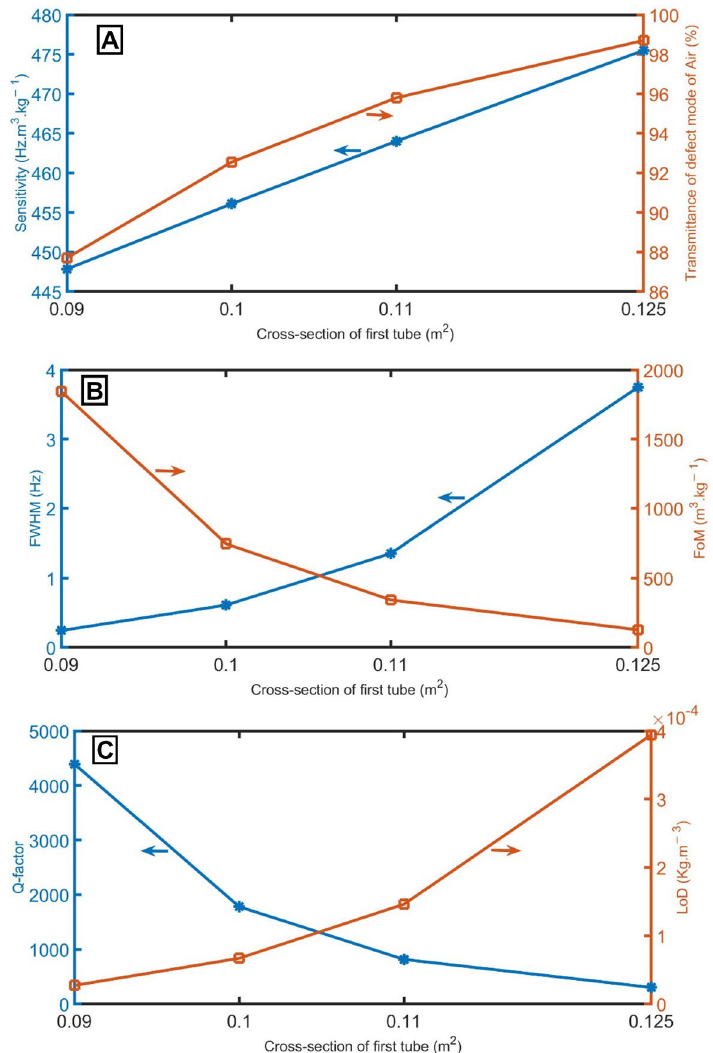
Figure 7. ( A ) sensitivity between air and pure CH 4 samples and transmittance of the resonant mode of air samples, ( B ) FWHM of the resonant mode of air samples and FoM , and ( C ) Q-factor and LoD of the proposed gas sensor at different cross-sections of the first tube of the unit